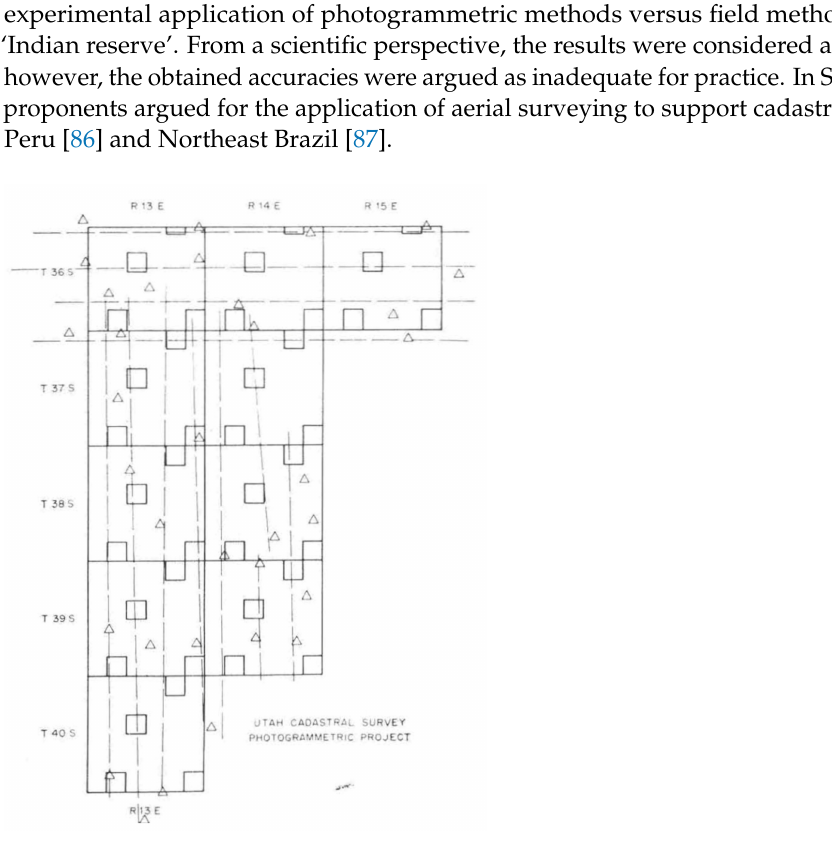
Figure 6. Fusion of photogrammetric and cadastral surveying in Utah, USA: photographic flight lines and control points (adapted from